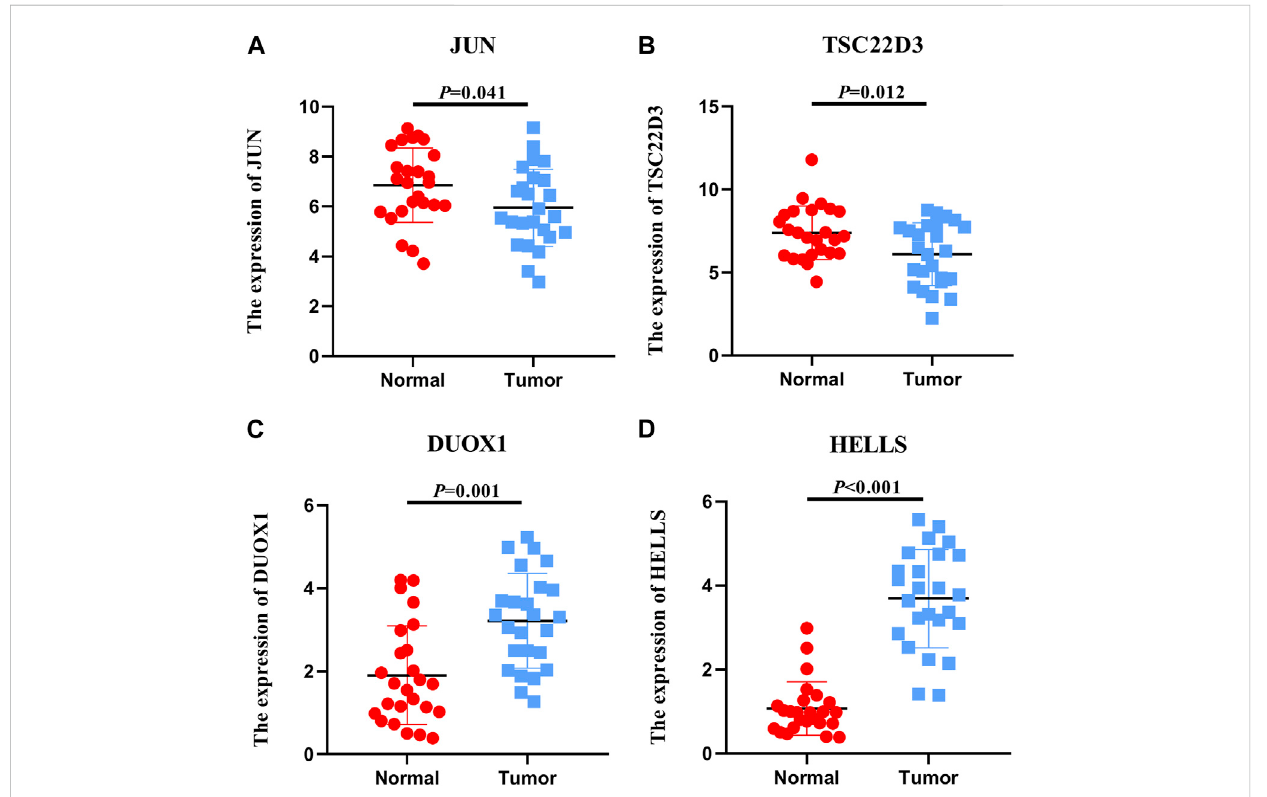
FIGURE 6 Expression levels of FRGs . Expression levels of 4 ferroptosis-related genes in 25 non-tumor tissues and 25 cervical cancer